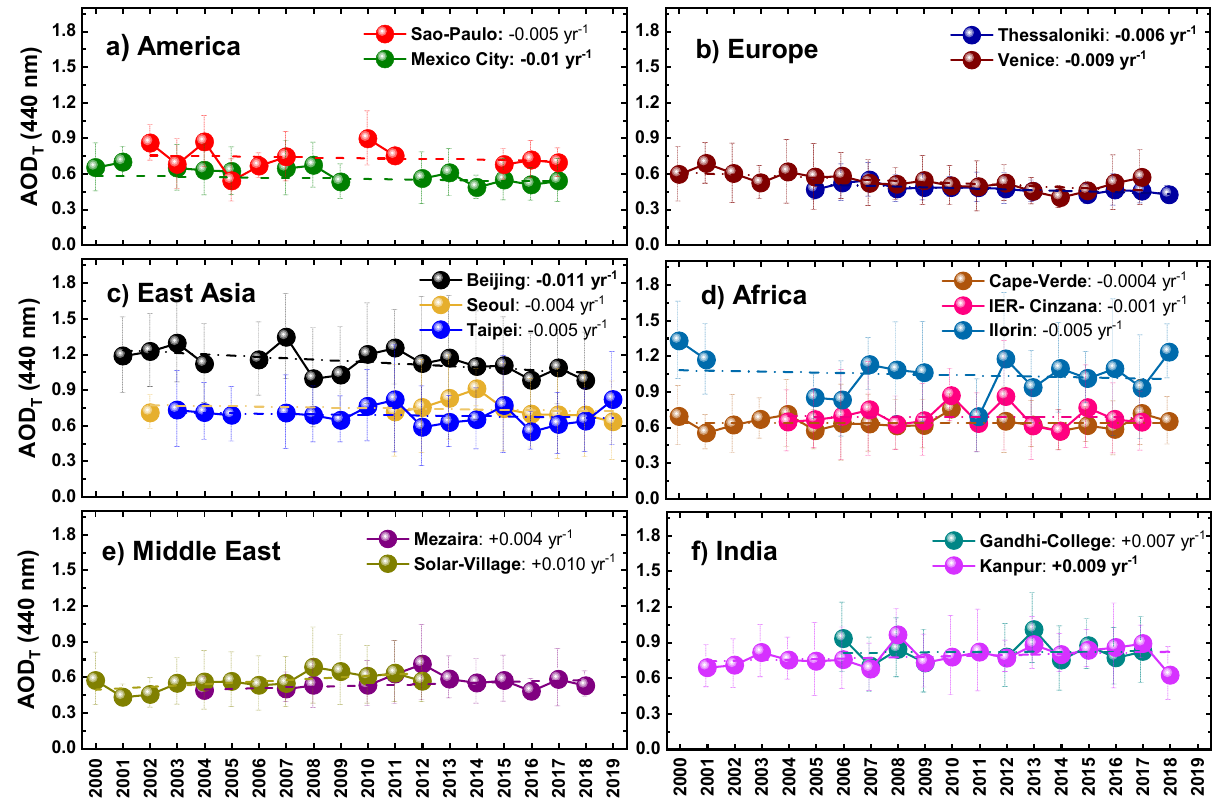
Figure 2. Variations of annual mean AOD T at 440 nm from 2000 to 2018 at fourteen sites. Error bars represent the standard deviation of the annual averages. (units AOD T yr − 1 ). None of the African and the Middle Eastern sites indicated a significant trend in AOD T during 2000–2018. The AOD T showed higher values at the Ilorin site (between 0.7 and 1.35) compared to the other African and Middle Eastern sites with the AOD T varia- tions between 0.3 to 0.9. Like the Middle Eastern sites, the AOD T represented comparable values over Gandhi College and Kanpur. The majority of the sites with significant trends depicted negative trends in AOD T , except for the Kanpur site, which exhibited a consid- erably positive trend with Sen’s slope of +0.009. The largest significant decline was found over Beijing, reaching − 0.011. Overall, the maximum AOD T values were identified over Beijing and Ilorin with variations higher than 0.7 throughout 2000–2018.